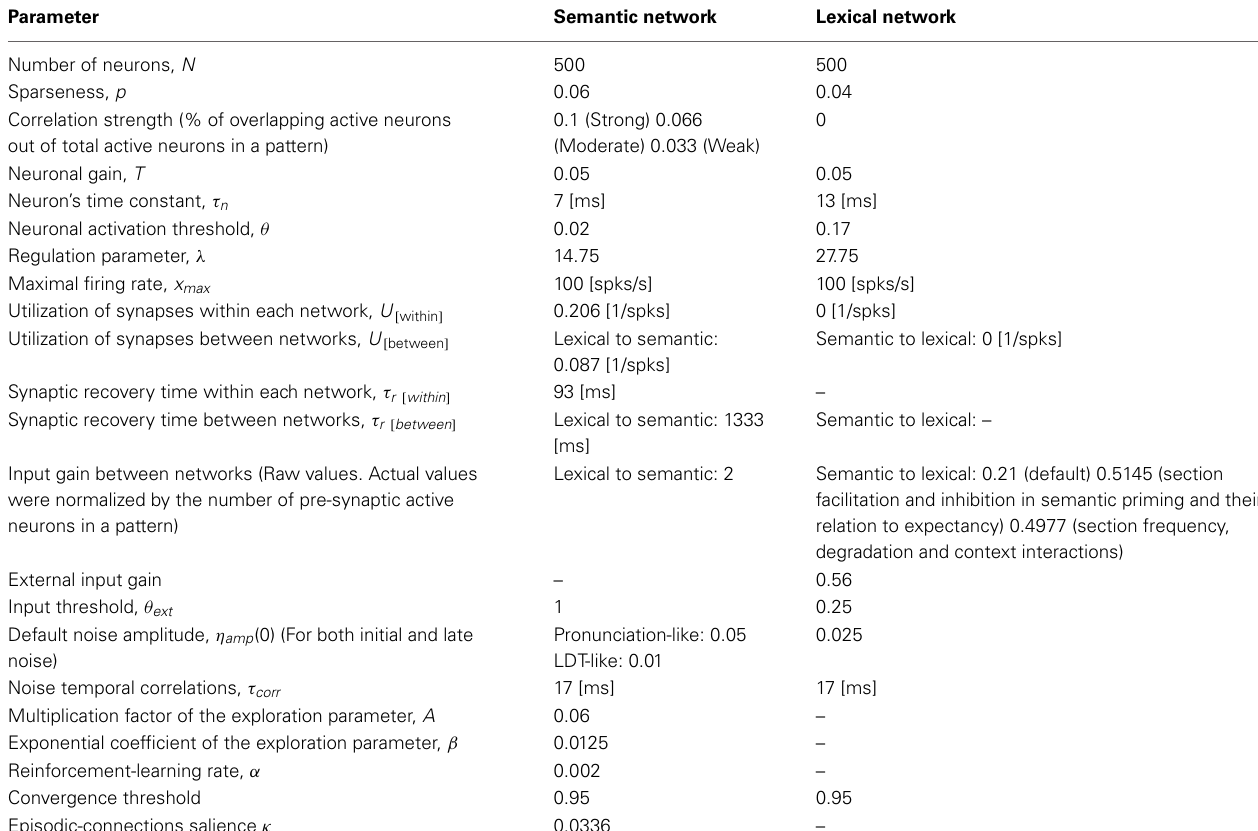
Table 3 | The semantic and lexical network parameters. Parameter